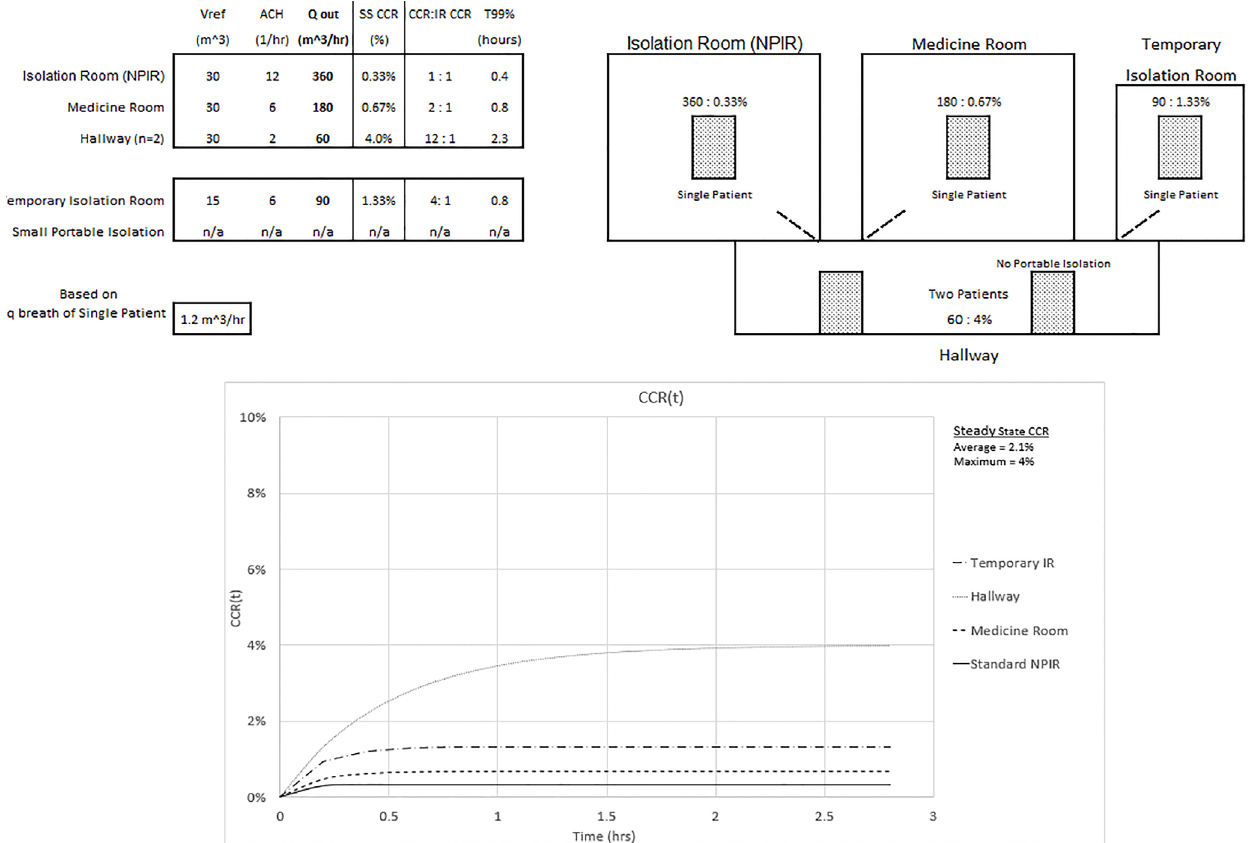
Figure 4. Configuration and CCR(t) of steady state average and maximum CCR exposures of 2.1% and 4% for equal time with all patients (average is 6 times the exposure of a standard isolation room CCR of 0.33%). NPIR, negative pressure isolation room; SS, steady state; CCR, contaminant concentration